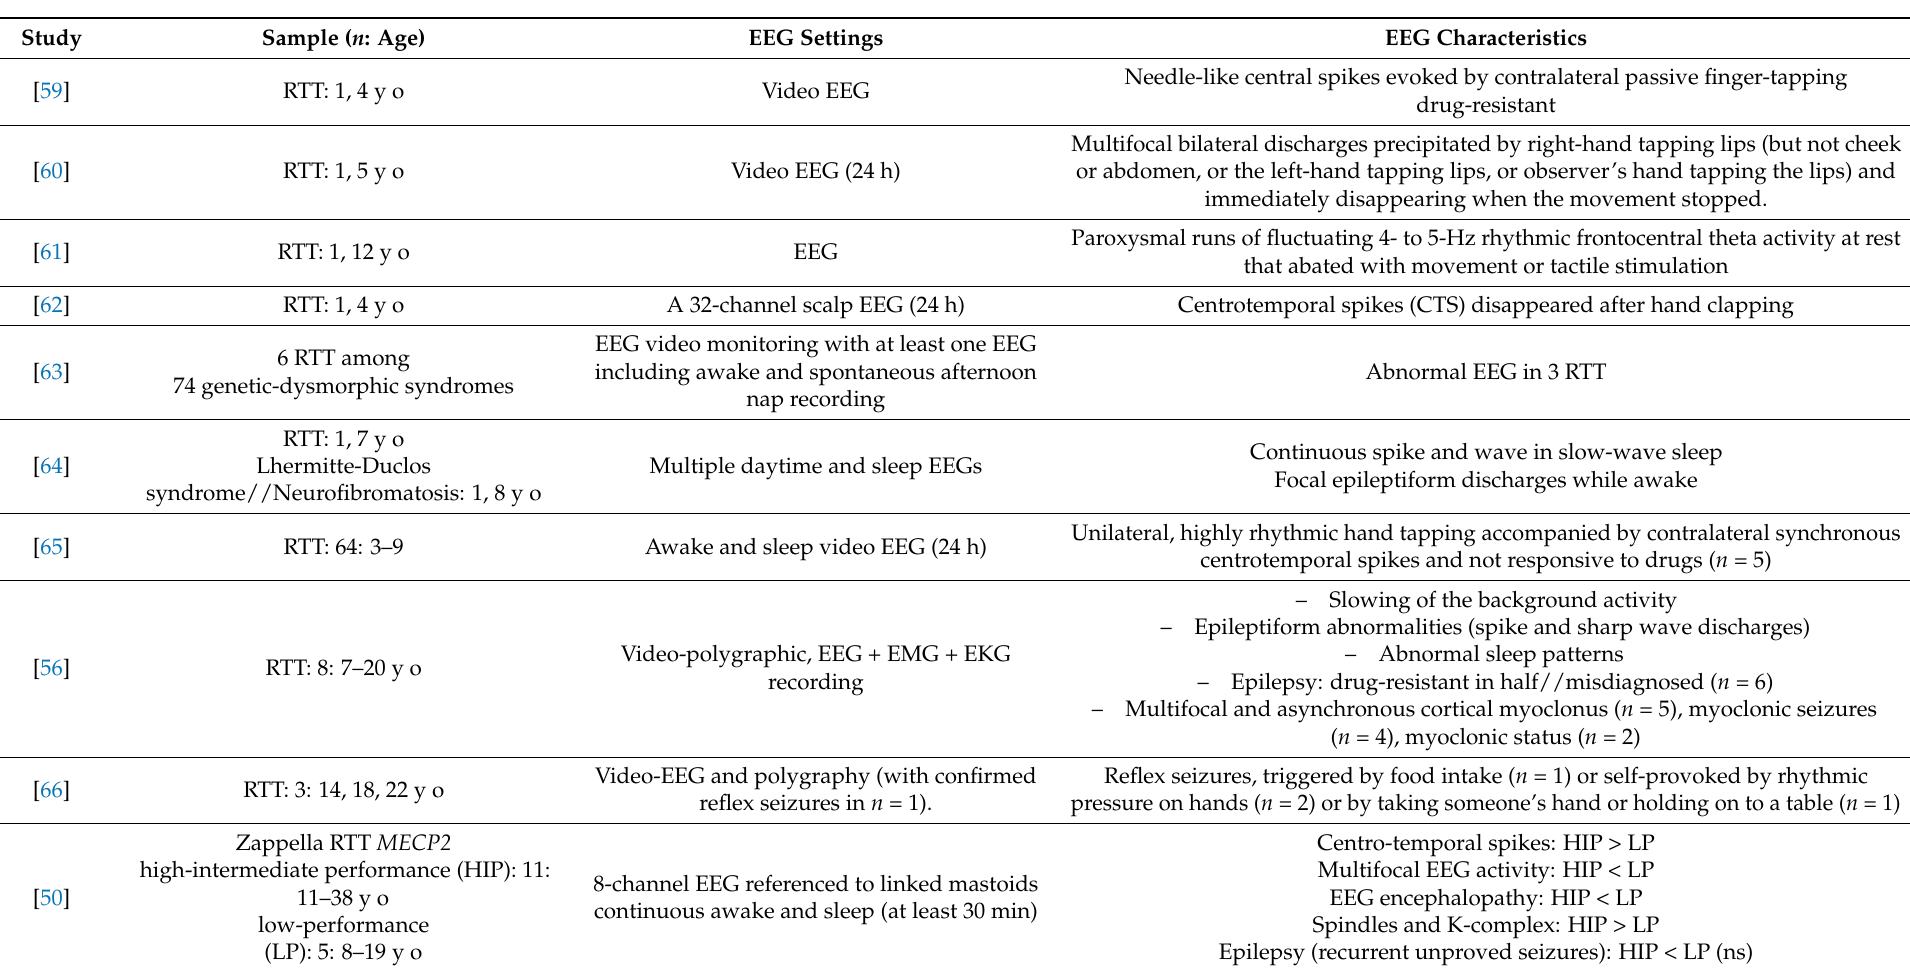
Table 1. Characteristics of studies with qualitative, clinical description of EEG